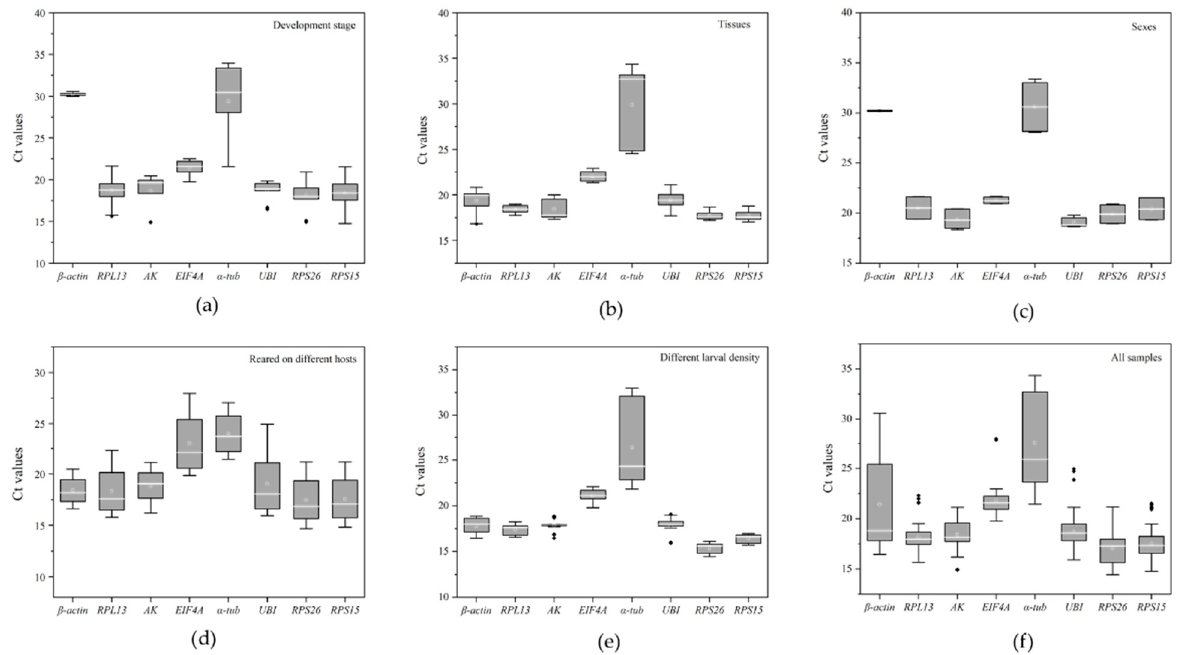
Figure 1. Box-whisker plots of expression patterns of candidate reference genes under different conditions. ( a ) Developmental stages. ( b ) Different tissues. ( c ) Gender. ( d ) Larvae feeding on different hosts. ( e ) Different larval densities. ( f ) All samples. The white line denotes the median in the box. The interquartile range is denoted by the upper and lower edges, which represent the 75th and 25th percentiles. The whisker caps on each box represent the maximum and minimum values.